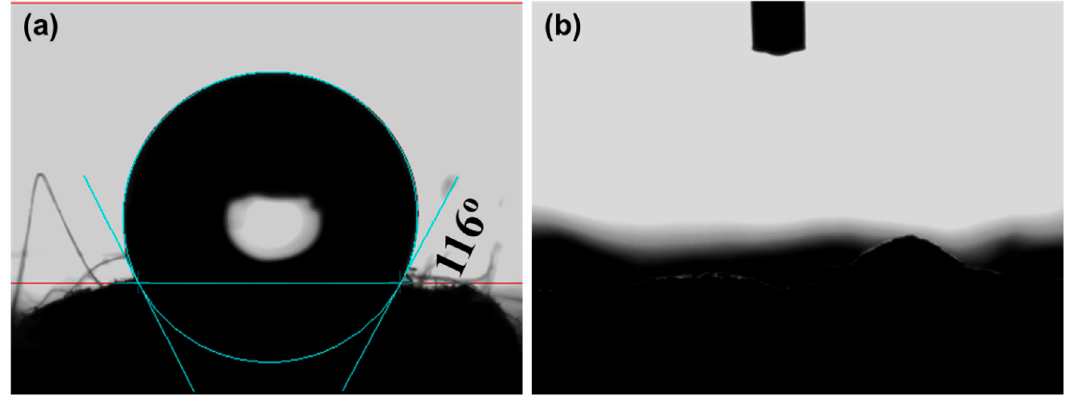
Figure 3. CA tests of ( a ) pristine PS and ( b ) SPS